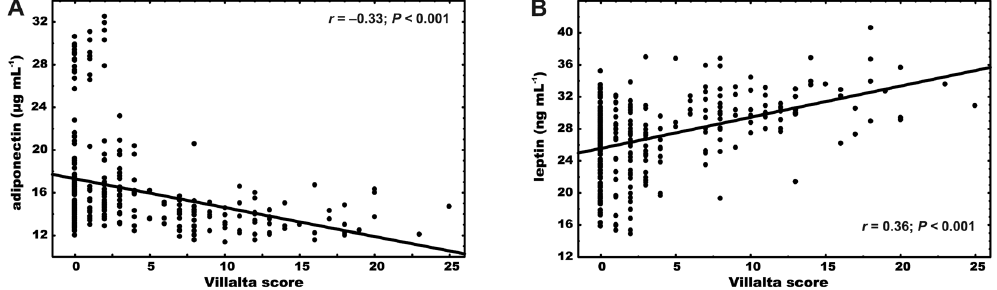
Figure 2. Correlations between the Villalta scores and two adipokines. The associations between variables measured 3 months since VTE in 309 patients - ( A ) adiponectin, ( B ) leptin and the Villalta score assessed after a two-year follow-up since venous thromboembolism (VTE)